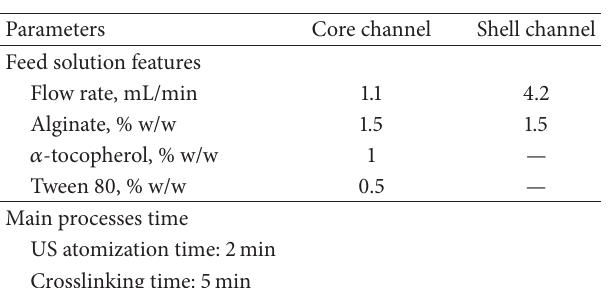
Table 1: Process parameters used in microdroplets production.